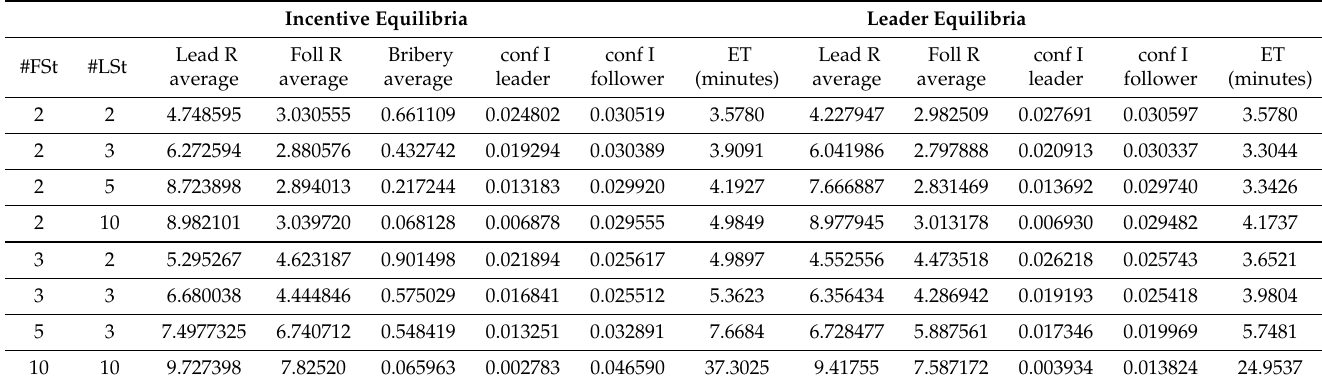
Table 13. Values using integer payoffs in the range − 10 to